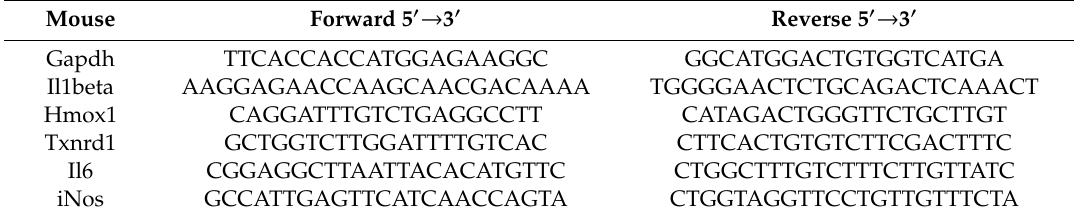
Table 1. Primers used for